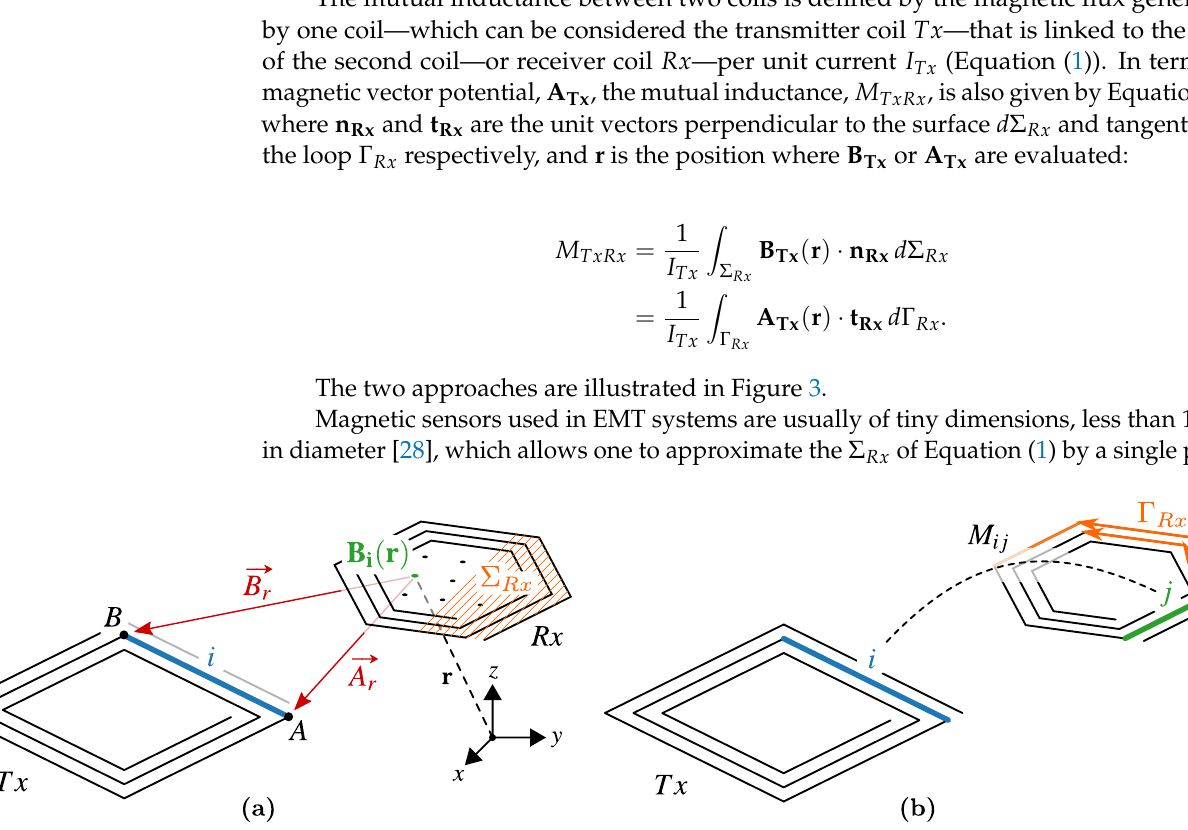
Figure 3. The mutual inductance between coil Tx and coil Rx can be ( a ) calculated from Equation (1) and numerically approximated by evaluation of the magnetic field generated by Tx across the area of Rx or ( b ) analytically calculated from Equation (2) as the sum of the partial mutual inductances between the straight filaments of the two